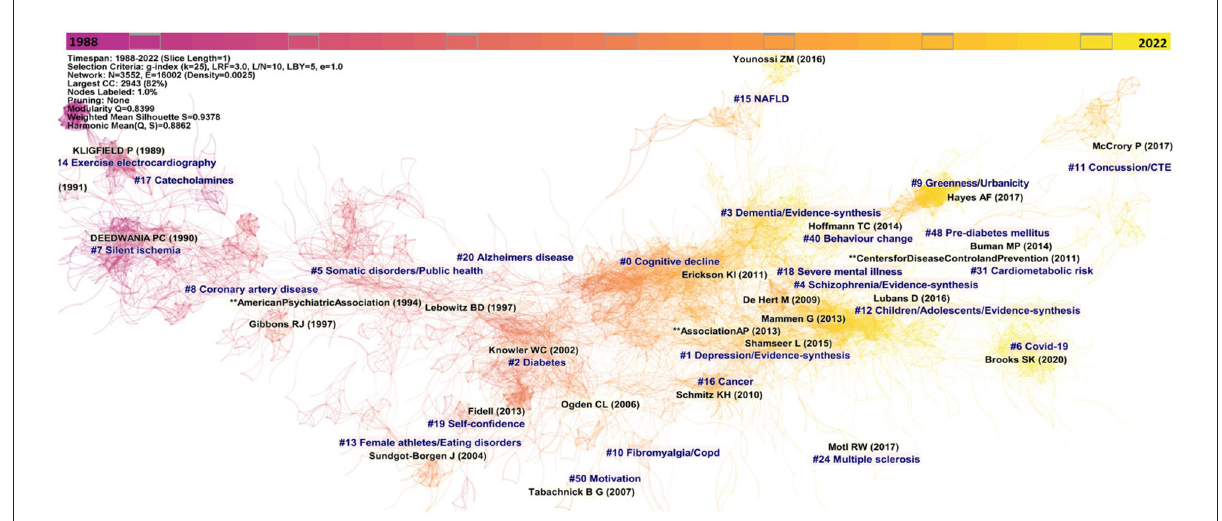
FIGURE1 Co-citation reference network with cluster visualization (1988–2021). The unit of measure are articles and constitutes nodes. Nodes are organized according to year of publication. The size of a node (article) is proportional to the number of times the node has been co-cited. Colored shades indicate the passage of the time, from past (purplish) to the present time